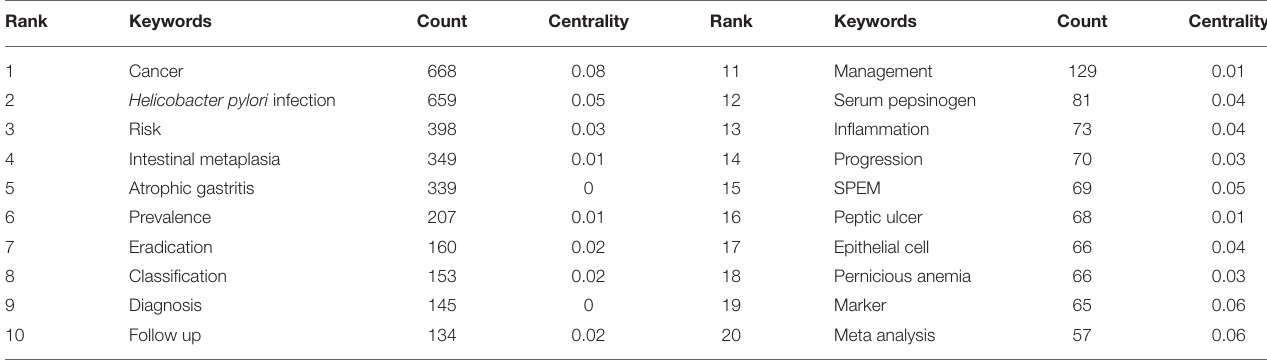
TABLE 6 | Top 20 keywords with the highest count in AG research.